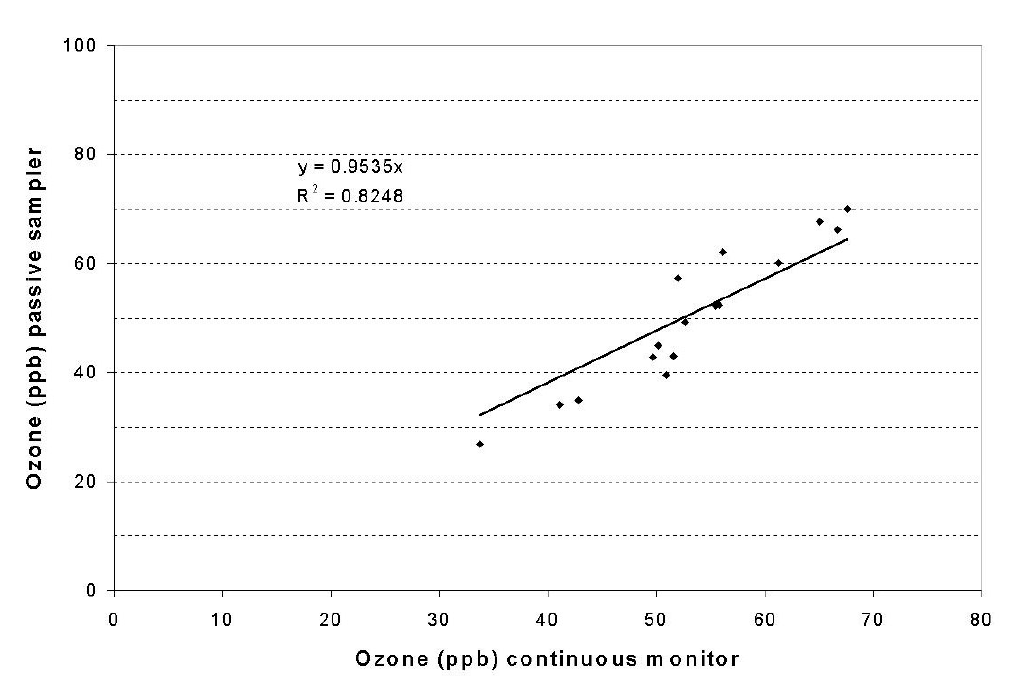
FIGURE 3. Comparison of ozone concentrations obtained with Ogawa passive samplers and a continuous electronic monitor.